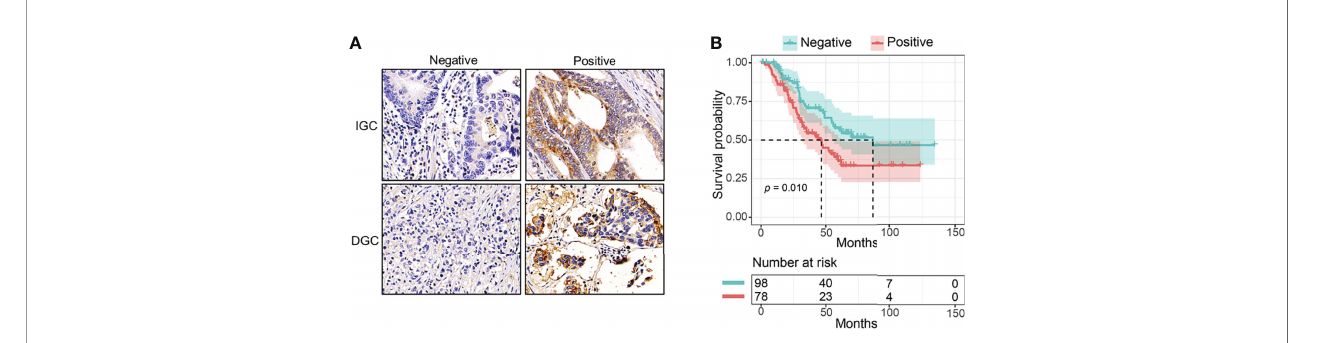
FIGURE 1 | The prognostic value of pFAK in GC patients. (A) Representative immunohistochemistry of positive or negative pFAK in GC paraf fi n samples. (B) Kaplan – Meier curves for pFAK-positive or -negative group in GC ( p = 0.010; HR = 1.777, 95% CI 1.131 to 2.791; median OS, 46.6 vs. 86.3 months, respectively). p -values were calculated by log-rank test. The number of patients at risk are below the that of the pFAK-negative group in GC ( p = 0.010; hazard ratio